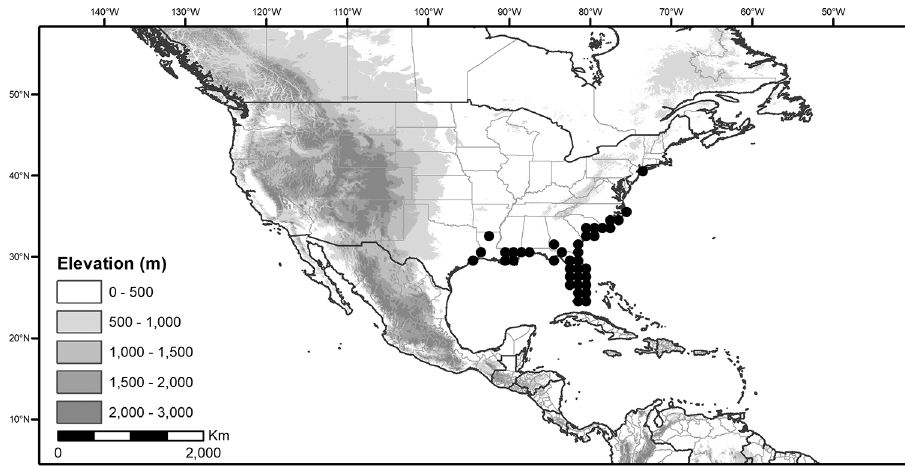
Figure 41. Distribution of Solanum pseudogracile